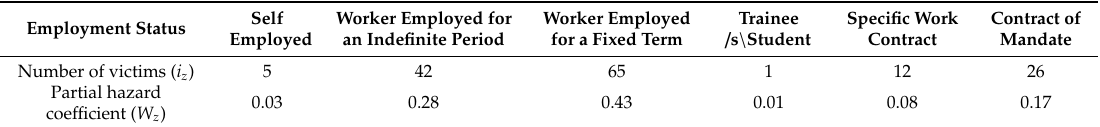
Table 8. Employment